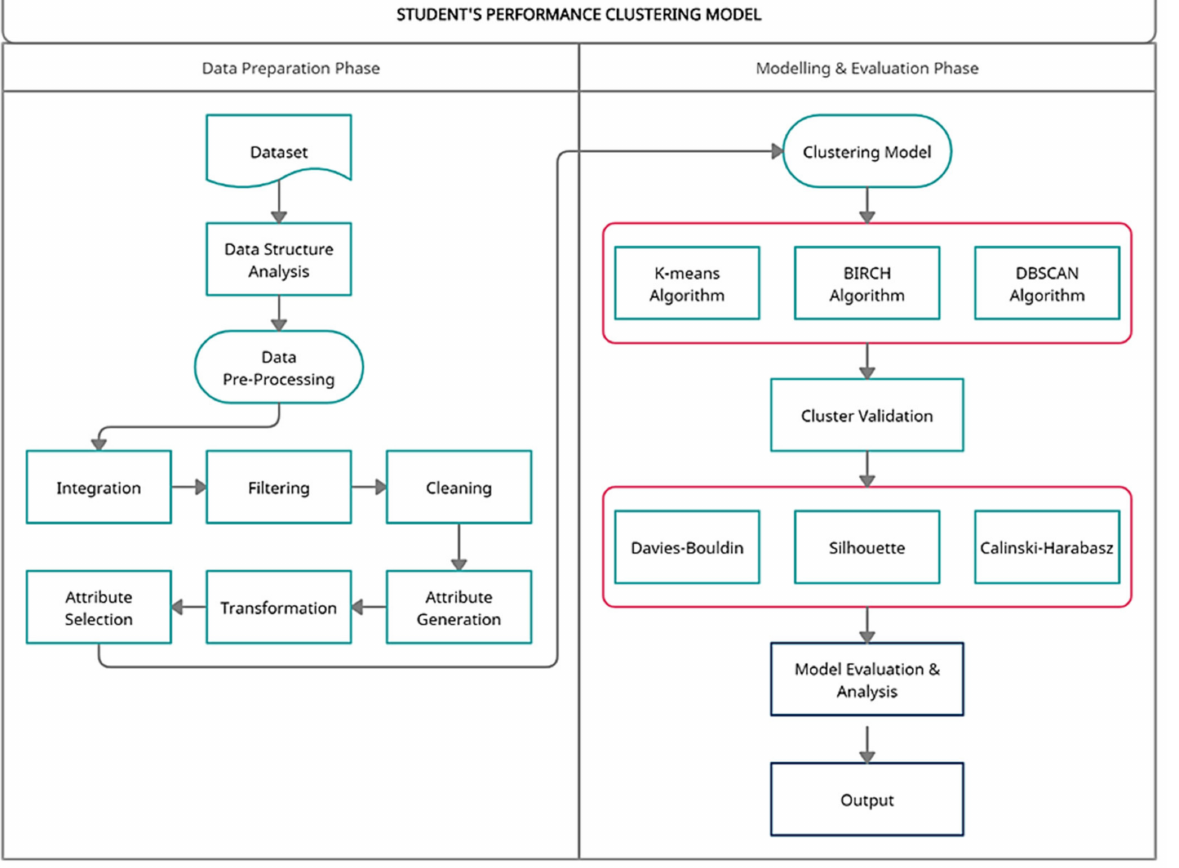
Figure 1. The framework for the B40 clustering